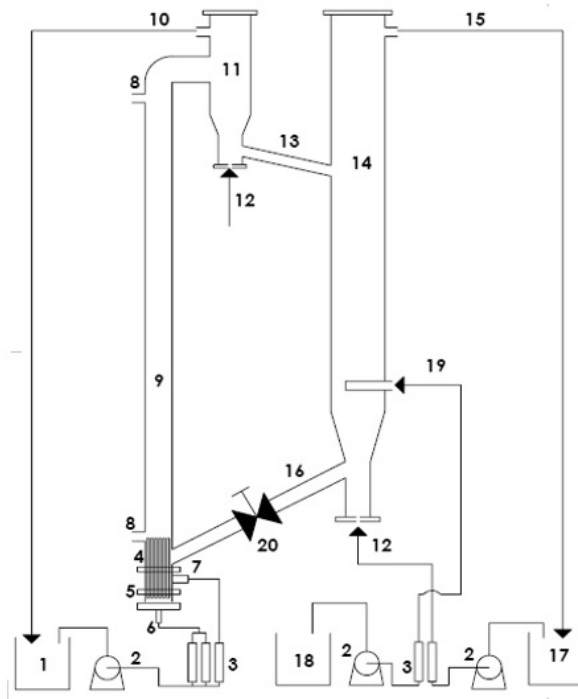
Figure 1. Schematic diagram of the experimental setup used. (1) Feed Tank; (2) Pump; (3) Rotameter;